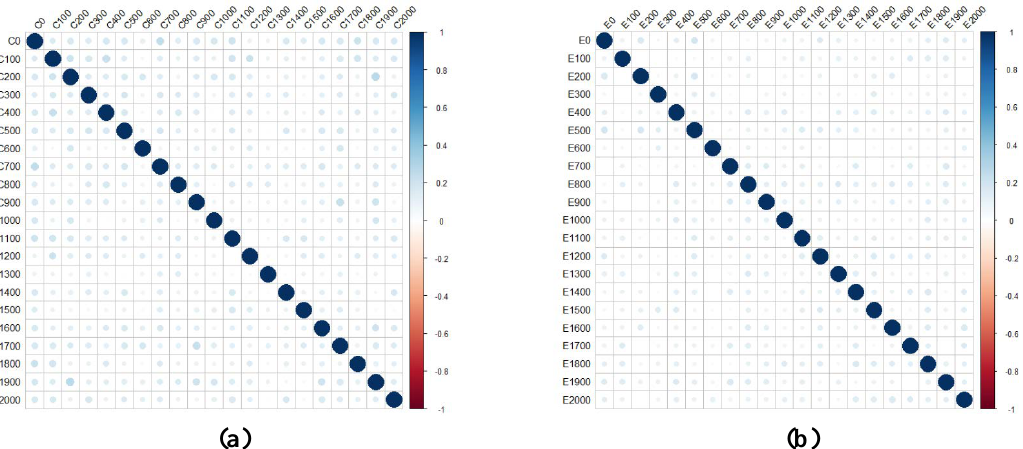
Figure 8. Heat map of Spearman coefficient between different locations in 3D printing samples: ( a ) columnar grain sample and ( b ) ultrafine equiaxed grain sample.